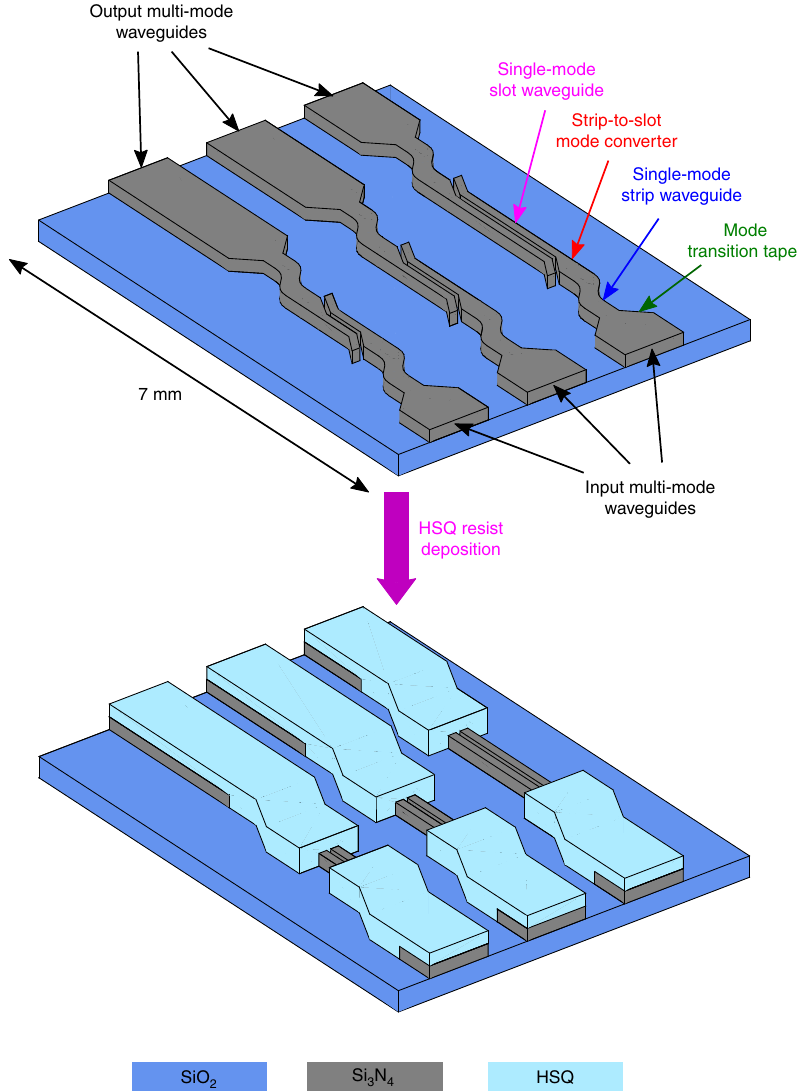
Fig. 1 Schematic of the silicon nitride waveguide chip design. The waveguide chip is 7 mm in length and it contains several waveguide channels with different dimensions. Each waveguide channel contains one single-mode slot waveguide, followed by a multi-mode strip waveguide, a multi-mode to single-mode transition taper, a single-mode strip waveguide and a linear strip-to-slot mode converter at the input and output sides of the corresponding channel. The strip waveguides, transition tapers and mode converters were covered with a HSQ-resist to protect them with the succeeding gain